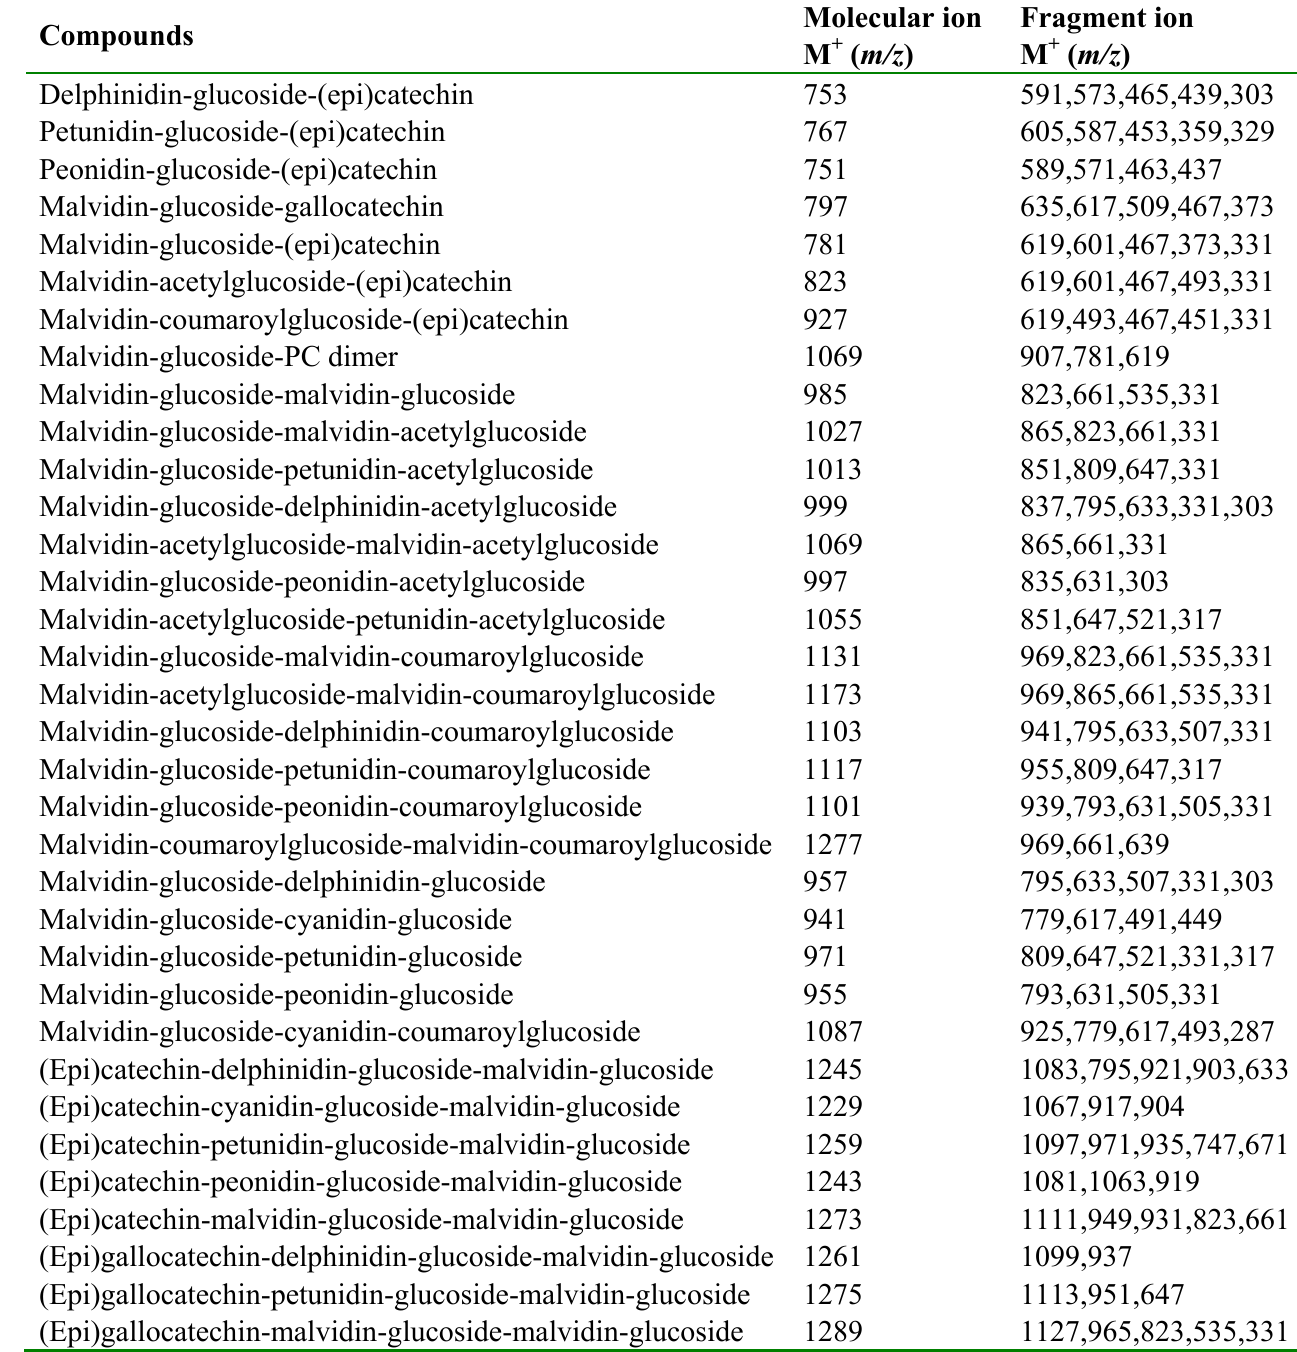
Table 2. The mass spectral data of some major products from direct condensation reactions of anthocyanins and/or flavan-3-ols